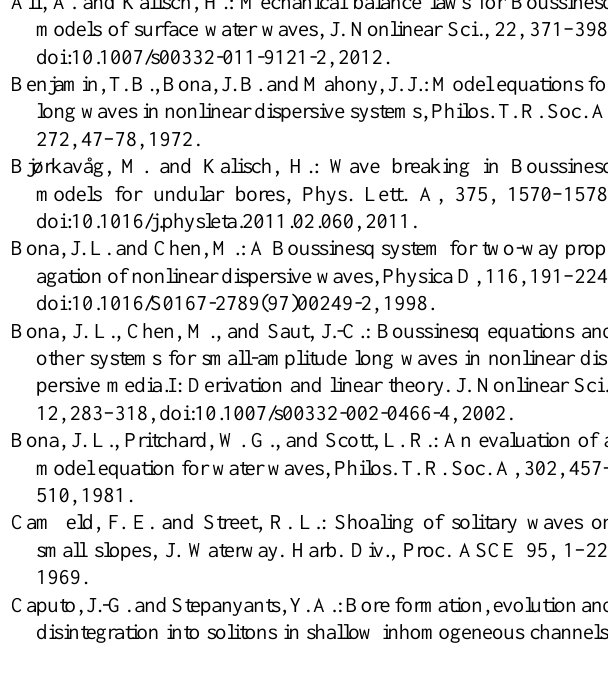
theory is used to derive a rather general shoaling law also including wave diffraction and dissipation. The shoaling relation derived be Pelinovsky et al. [27] reduces to Green’s law in the case that nonlinearity and dispersion are neglected. In the case of a periodic sequence of solitary waves, the relation reduces to a ’nonlinear’ Green’s law, such as found by Ostrovsky and Pelinovsky [22]. See also Ostrovsky and Pelinovsky [23] for nonlinear wave refraction.